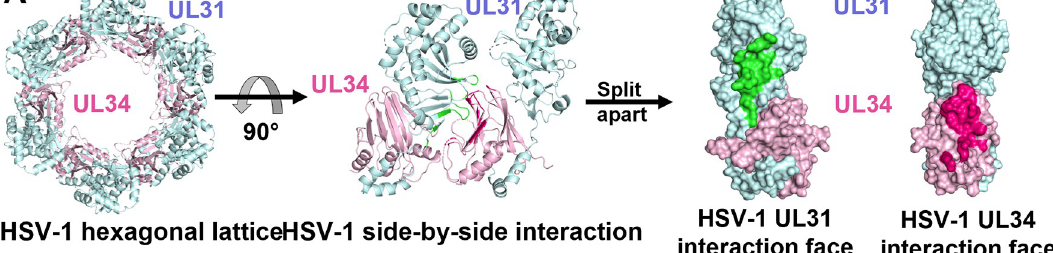
PLOS Pathogens| https://doi.org/10.1371/journal.ppat.1010623 July 8,